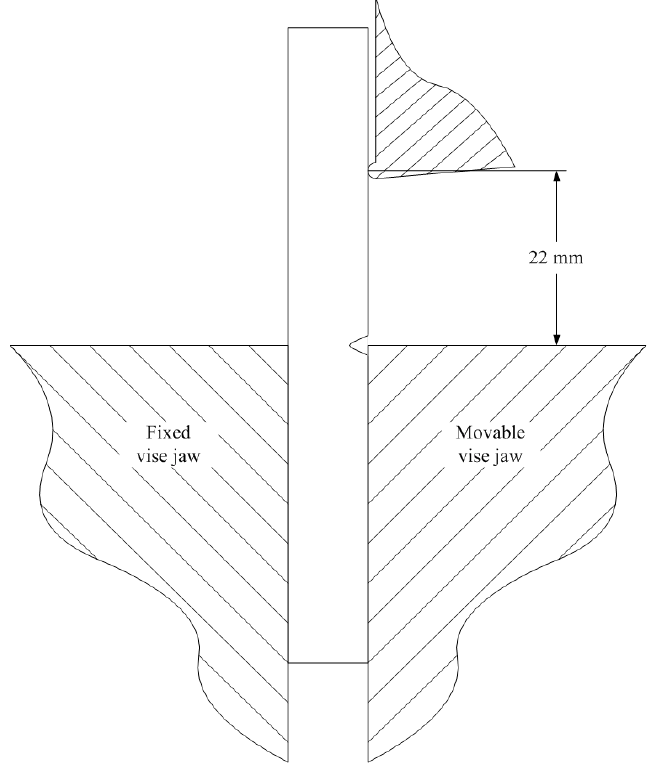
Figure 1. Illustration of the notched Izod impact test.